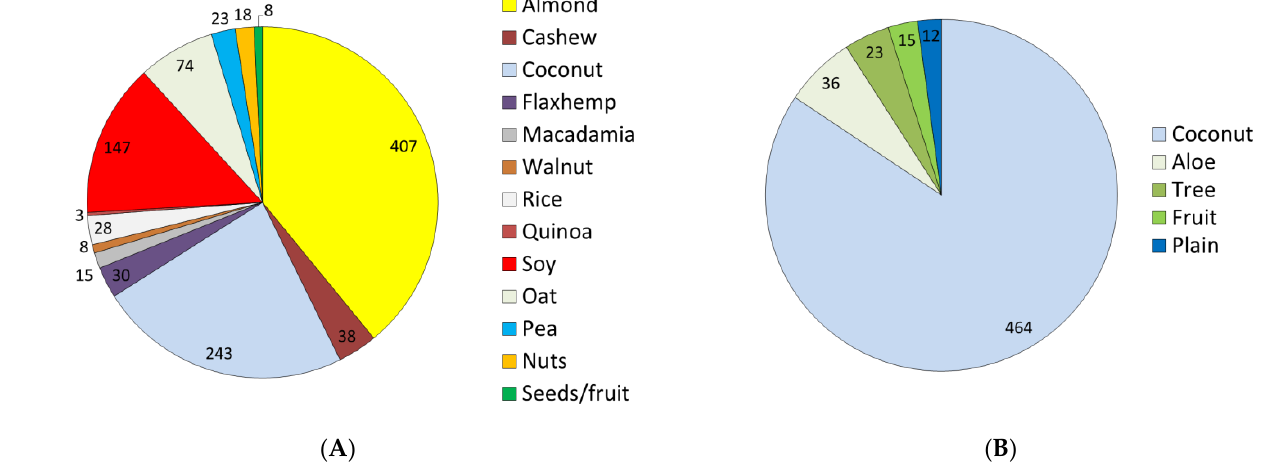
Figure 1. PB milk alternatives ( A ) and PB waters ( B ) by main ingredient ( B ).